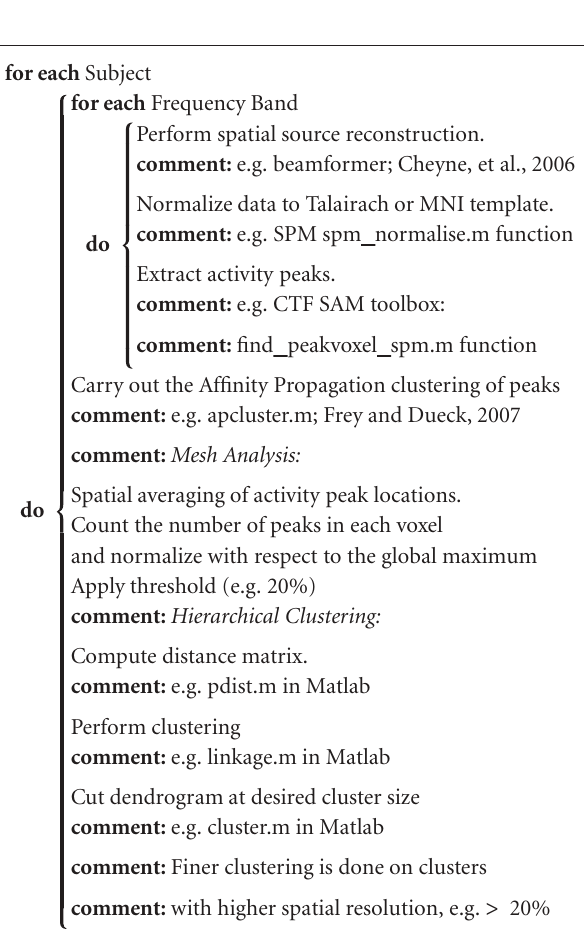
Algorithm 2.1 | Adaptive